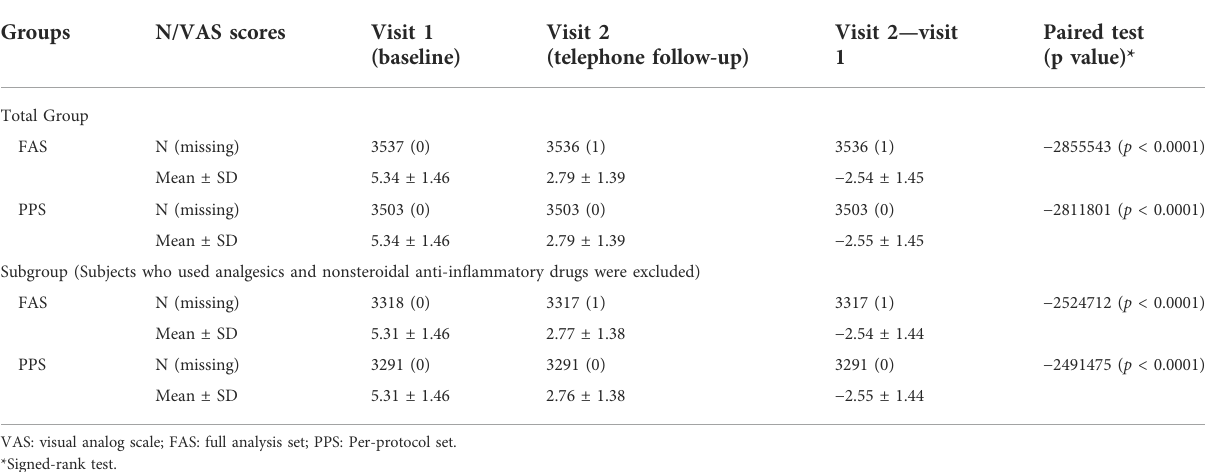
TABLE 5 VAS scores of the subjects.